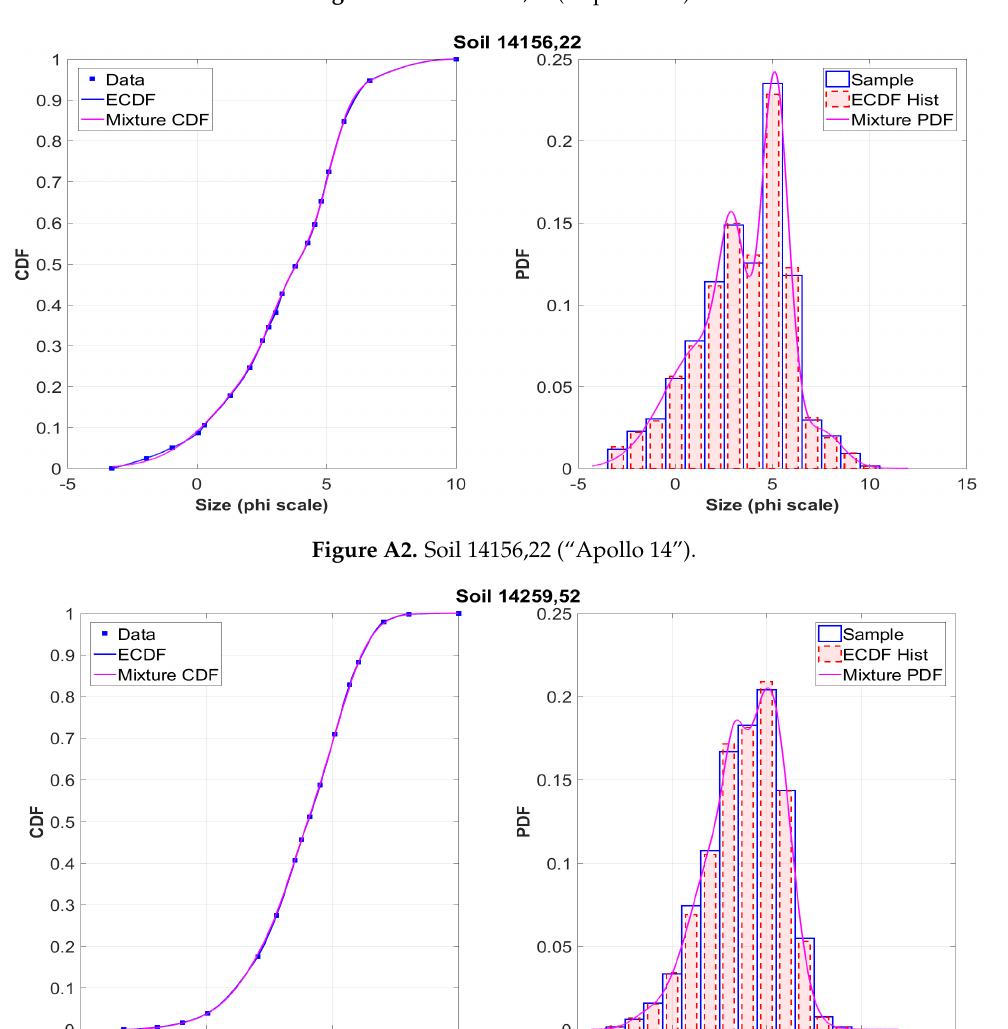
Figure A1. Soil 12042,24 (“Apollo 12”).